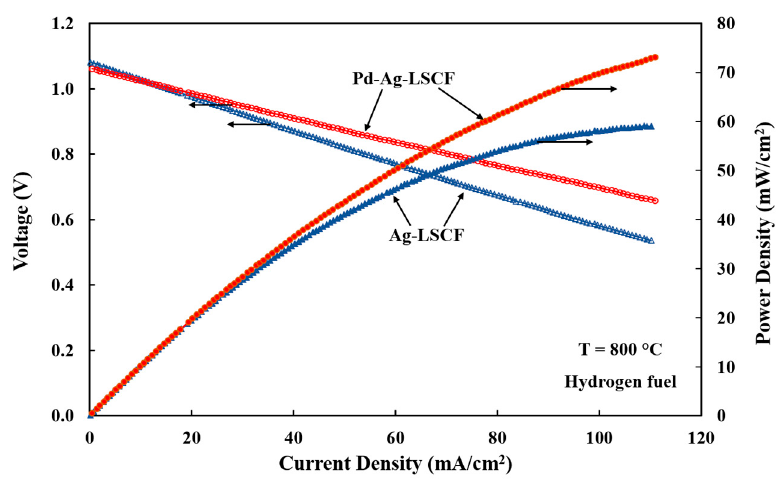
Figure 7. Voltage-current-power density characteristics with hydrogen as a fuel for Ag- LSCF//YSZ//GDC/LSCF cell and Pd-Ag-LSCF//YSZ//GDC/LSCF cell (hydrogen = 75 mL/min, air = 75 mL/min) at 800 °C.